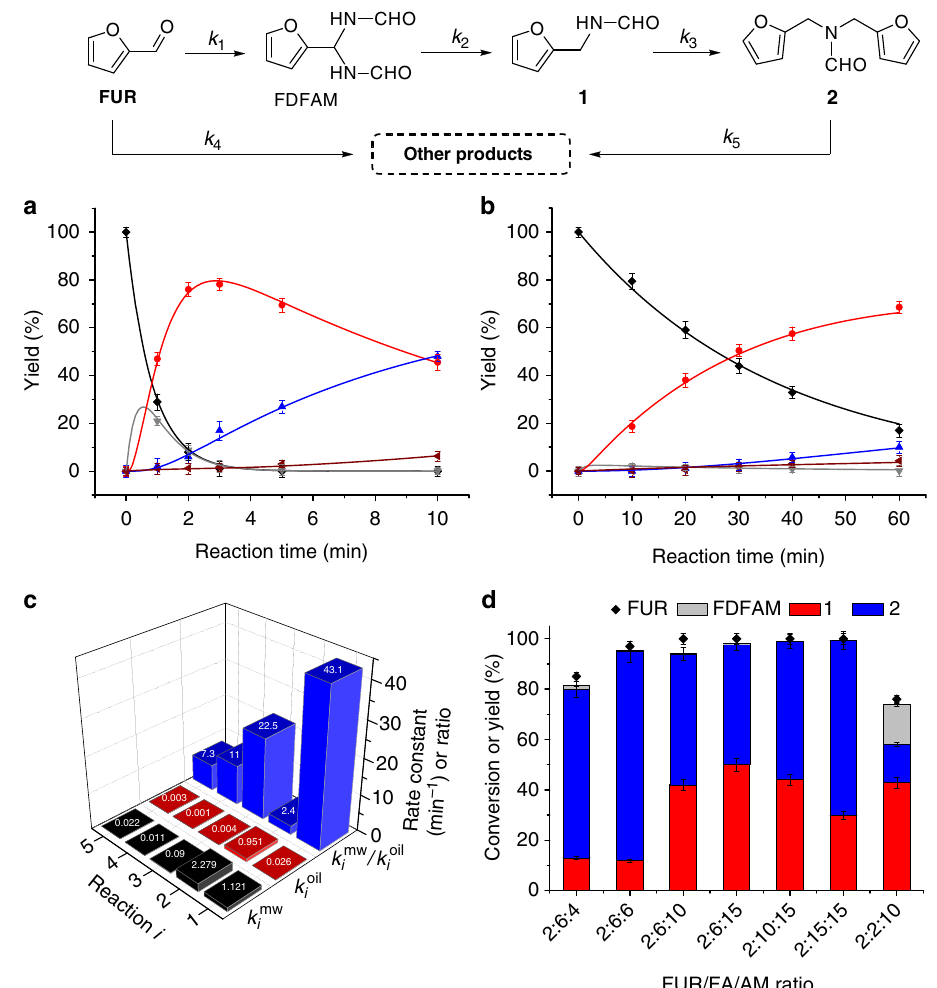
Fig. 2 Amination of furfural (FUR) with formamide (AM). Time course for reactants heated by a microwave and b oil bath modeled with the assumption of pseudo- fi rst-order reaction kinetics (black diamond, FUR; gray triangle, FDFAM; red circle, 1 ; blue triangle, 2 ; brown triangle, Other products). Rate constants of c microwave ( k mw i ) and oil heating ( k oil i ) and ratios ( k mw i / k oil i ) for cascade reactions ( i ) at reaction conditions (2 mmol FUR, 6 mmol FA, 10 mmol AM, 180 °C). Product distributions for d furfural/formic acid/formamide molar ratios with FUR set at reaction conditions (2 mmol FUR, 200 °C, 3 min). Error bars with standard deviation ( σ ) of ≤